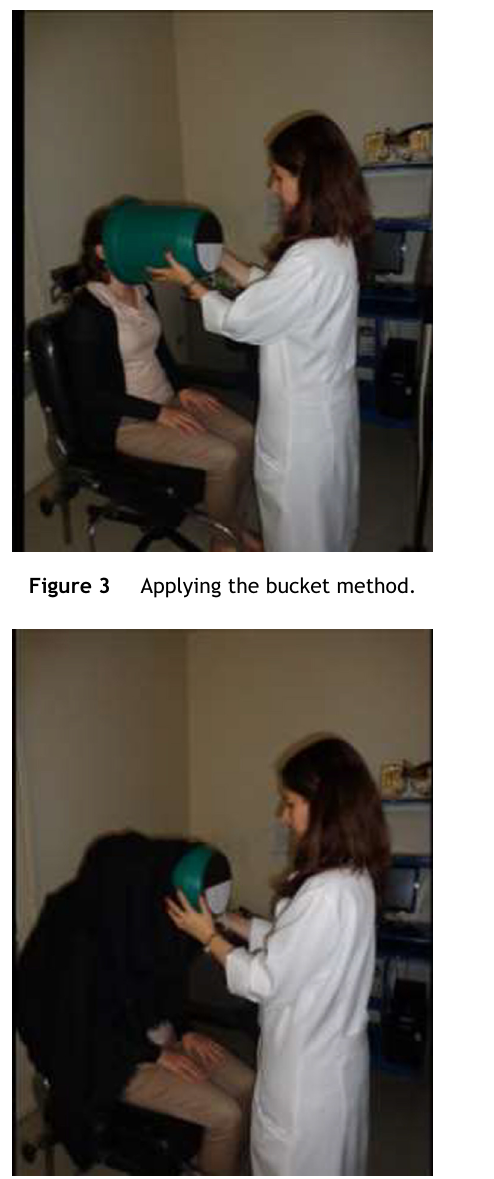
Applying the bucket method using a dark cloth. ( ˛ = 0.05) and SPSS v. 19 for Windows and Office Excel 2007 were used in the statistical analysis.